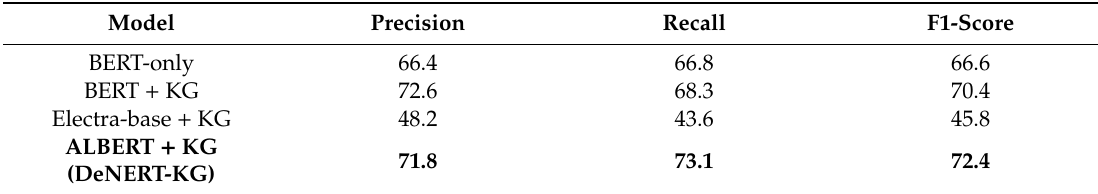
Table 6. Experiment result on TACRED